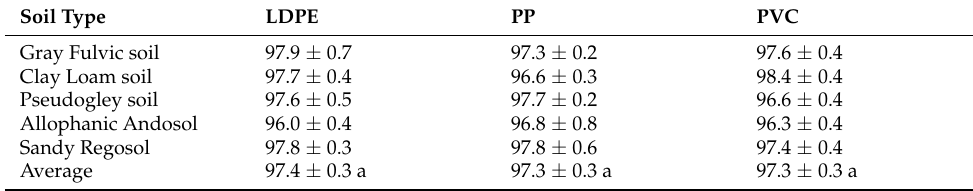
Table 4. The recovery rates of the large plastic particles (1–2 mm) from the five different soils by the oil and density separation method using a mixture of canola oil and NaCl solution.